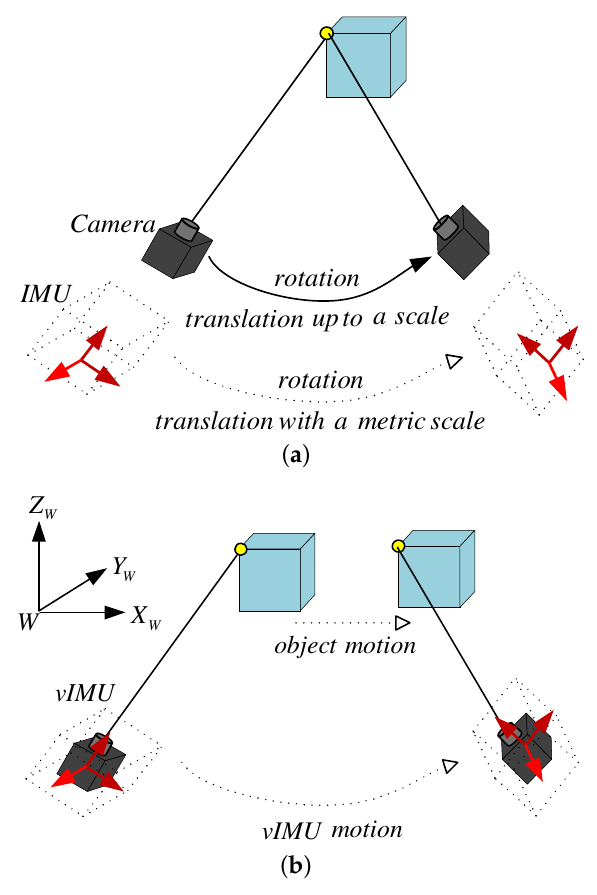
Figure 1. Static and dynamic scene. ( a ) in a static scene, a camera integrated with an IMU can infer the information of the metric scale; ( b ) in a dynamic scene, the problem is how to accurately infer both the vIMU motion and the object